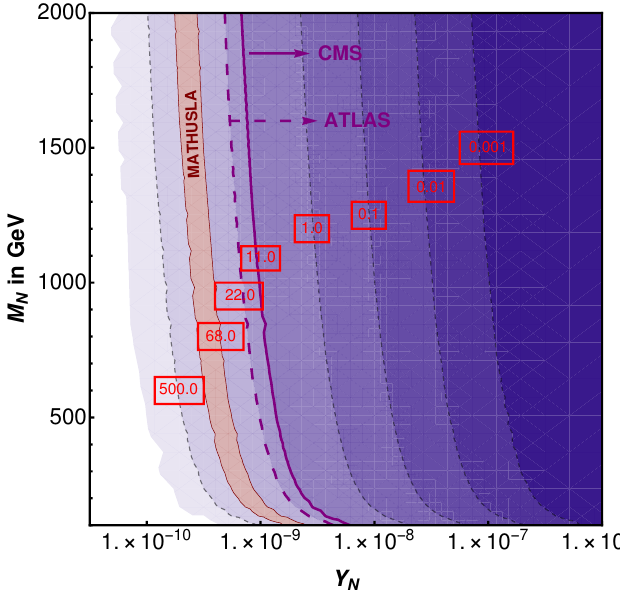
Figure 8. The displaced decay length of RHN is presented in Y N − M N plane. Different regions of decay length from 0.001 m to 500 m are marked with red boxes. The CMS, ATLAS and MATHUSLA boundaries are shown in magenta solid, magenta dashed and brown thick lines,